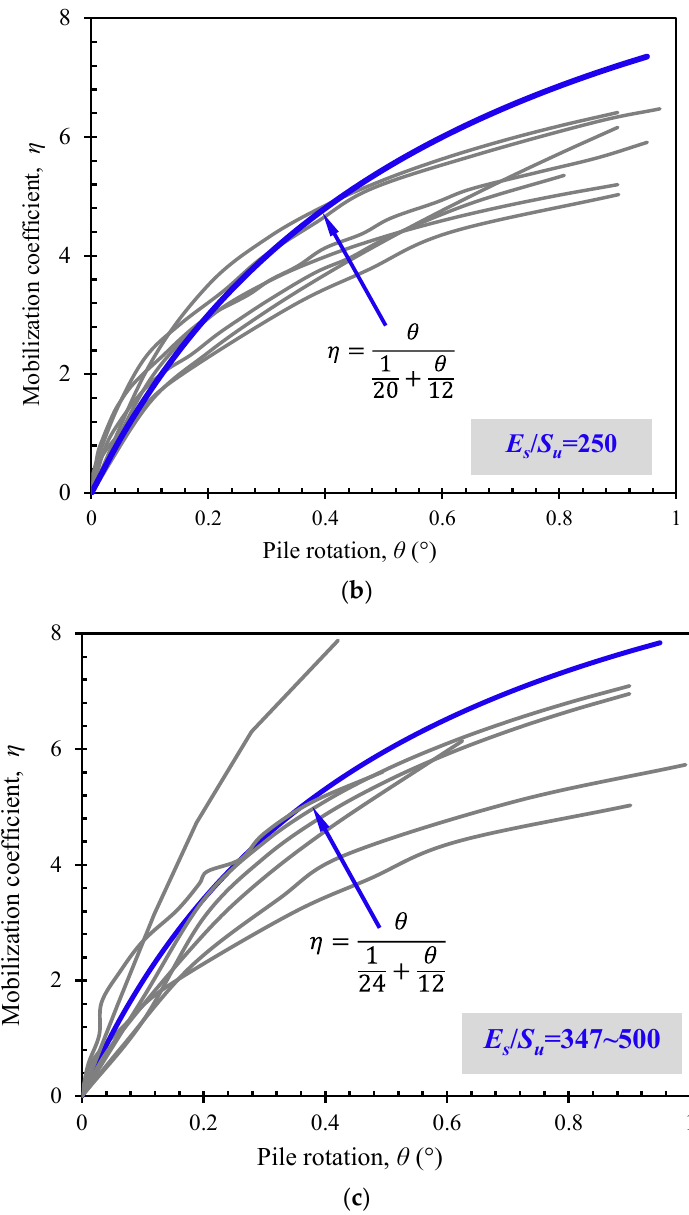
Figure 8. Correlations between pile rotation and mobilization coefficient for various ground condi- tions: ( a ) E s / S u = 200; ( b ) E s / S u = 250; ( c ) E s / S u = 347~500.